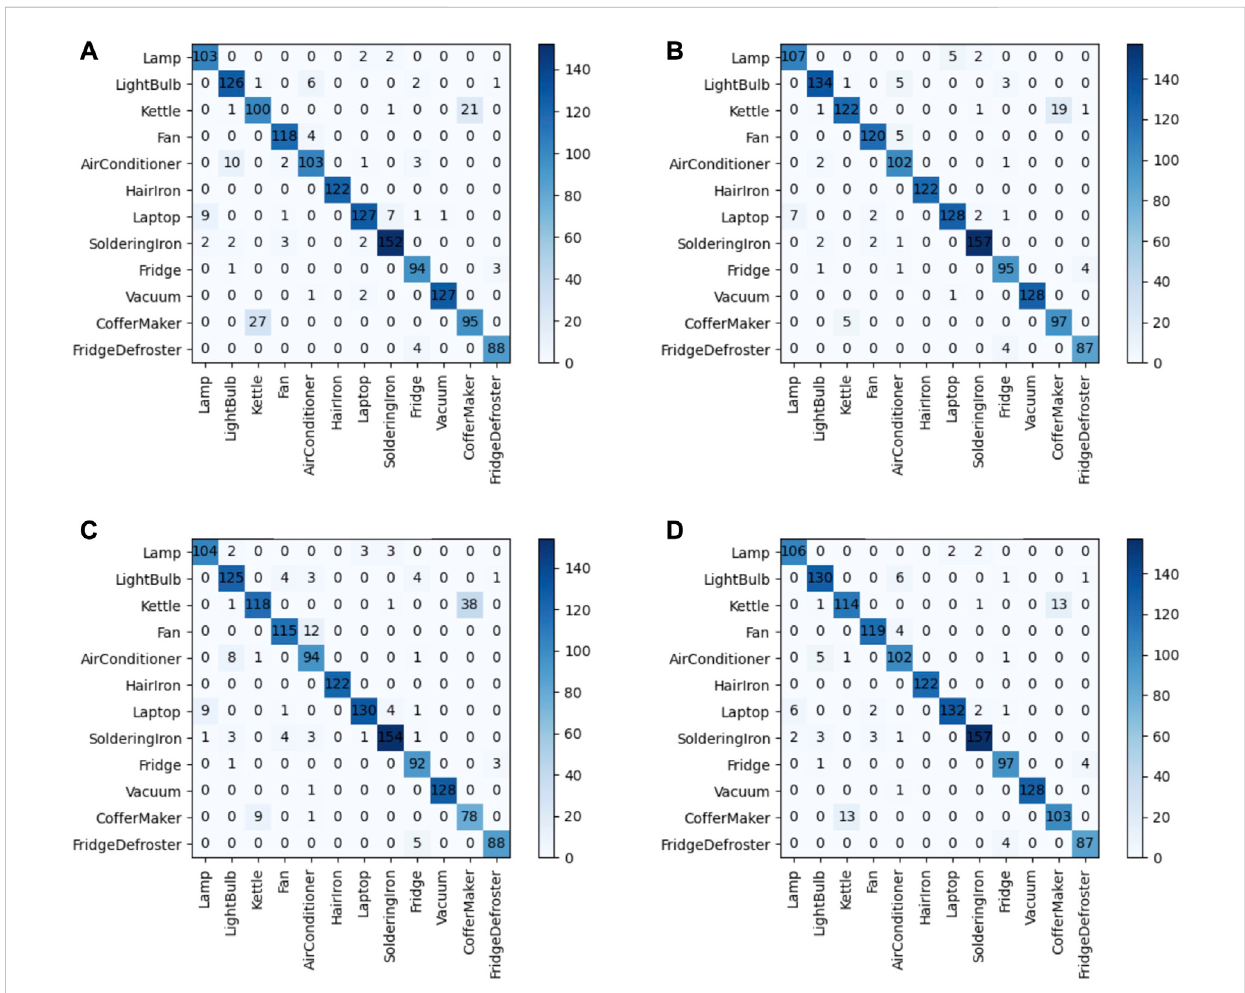
FIGURE 4 (A) V-I trajectory map without DRO addition. (B) V-I trajectory map with DRO addition. (C) Euclidean distance matrix without DRO addition. (D) Euclidean distance matrix with DRO